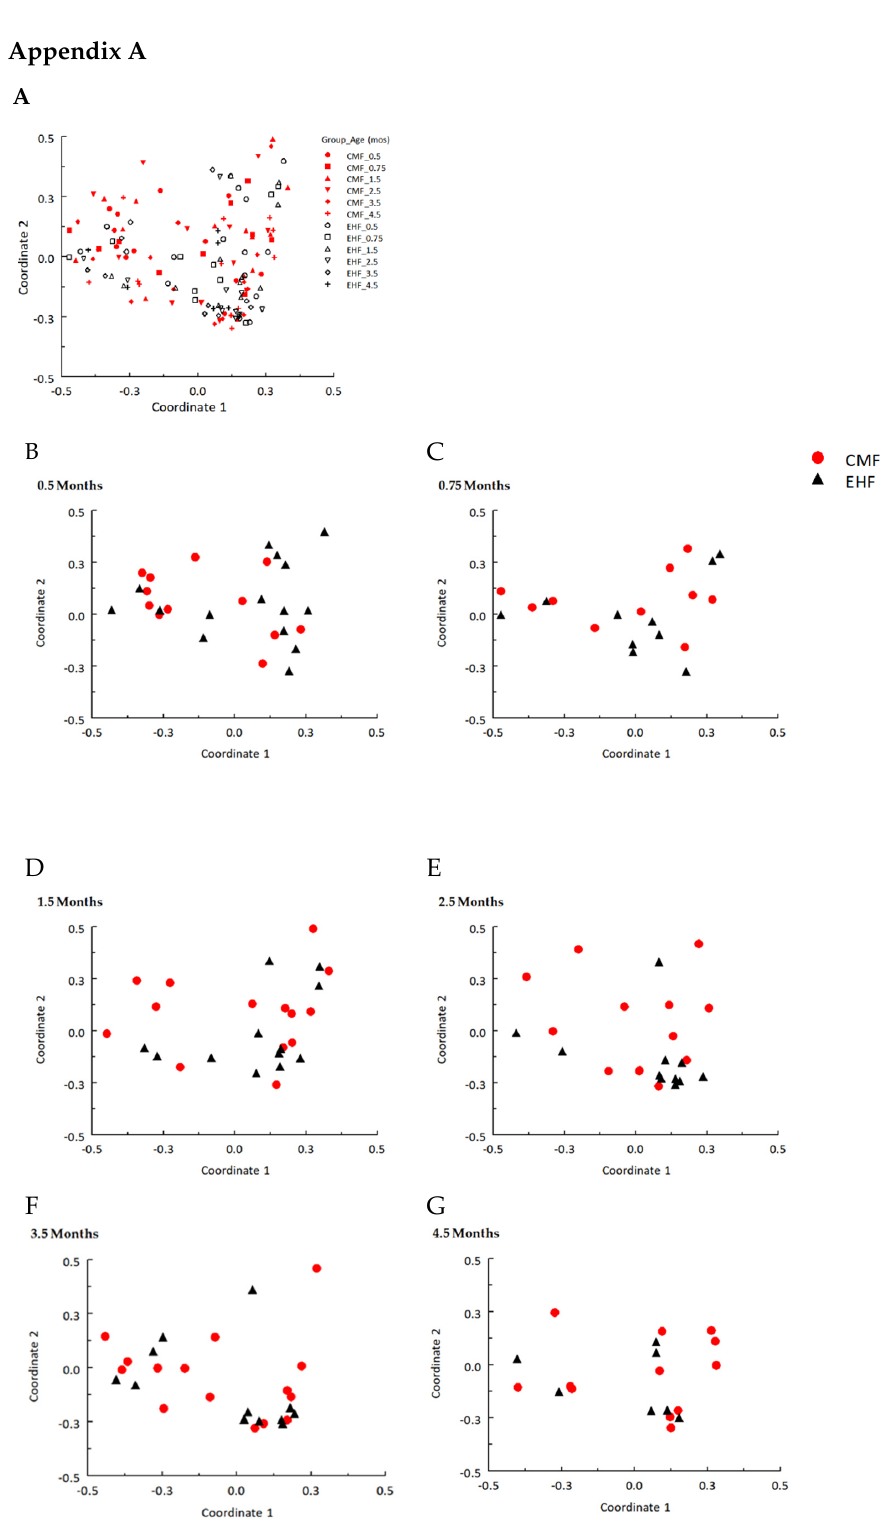
Figure A1. Multidimensional scaling plot of beta diversity based on Bray–Curtis distance metric for CMF and EHF groups showing ( A ) all ages combined and ( B – G ) at each time point. There were no significant differences between CMF (cow milk formula, red symbols) and EHF (extensive protein hydrolysate formula, black symbols) groups at 0.5, 0.75, and 1.5 months ( p > 0.05, Permutational Multivariate Analysis of Variance (PERMANOVA) tests on Bray–Curtis distances), but there were significant group differences at 2.5 ( p = 0.03), 3.5 ( p = 0.02), and 4.5 months ( p = 0.03); PERMANOVA tests on Bray–Curtis